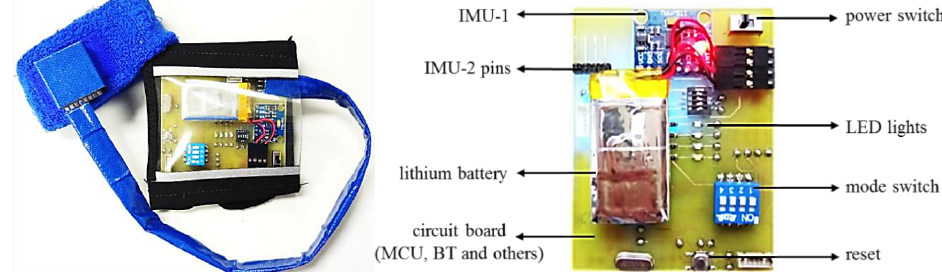
Figure 2. Upper extremity throwing action recognition device and the embedded circuit board.